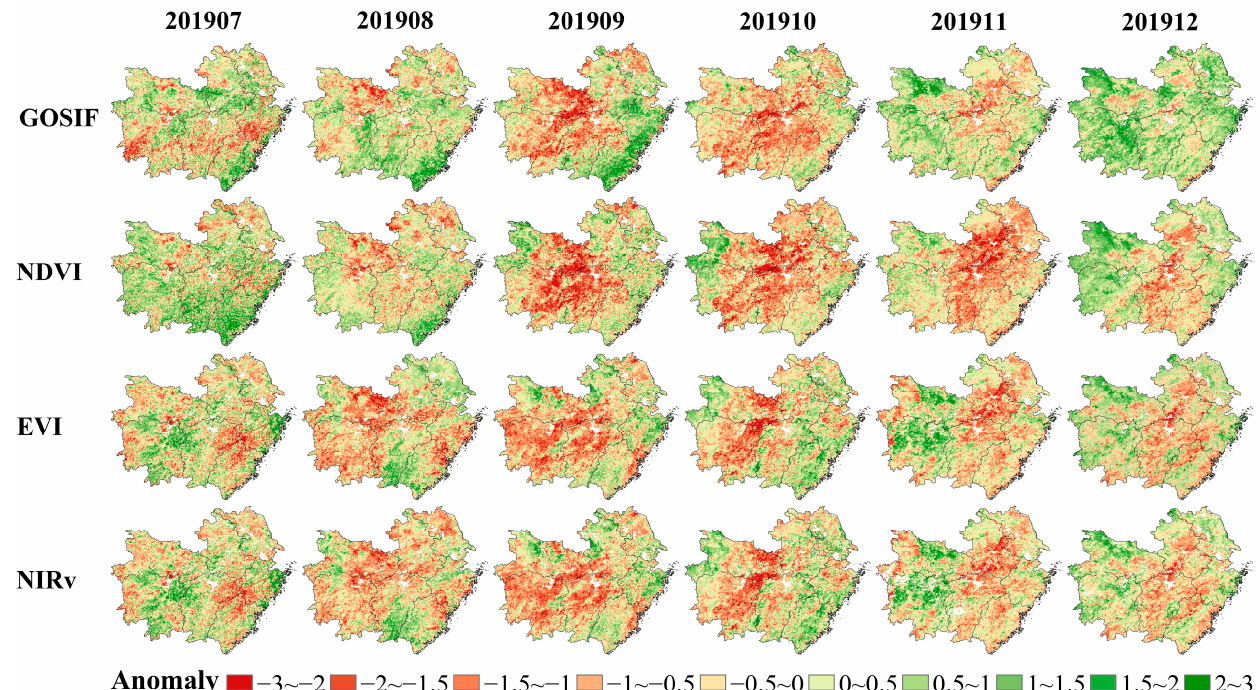
Figure 10. Spatial distributions of the standardized anomalies of GOSIF, NDVI, EVI, and NIRv from July to December 2019.